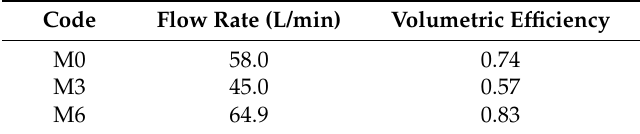
Table 7. Flow rate and volumetric efficiency at 5000 rpm for different